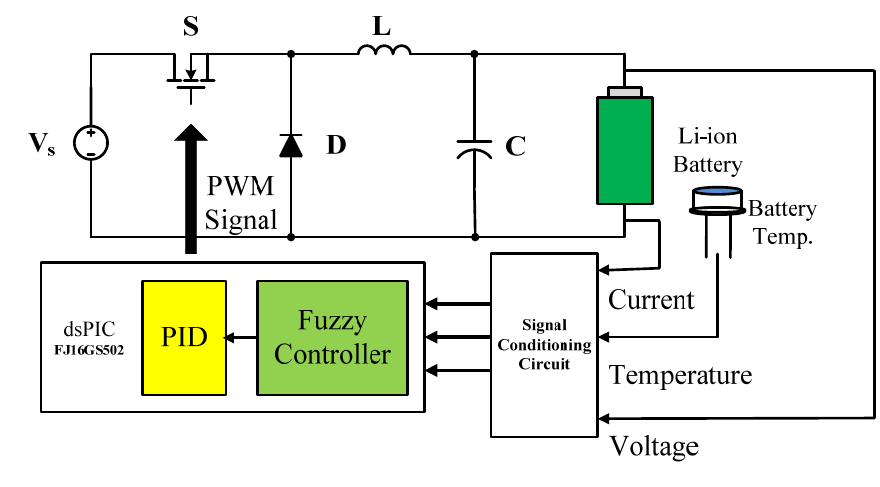
Figure 1. Hardware configuration of the proposed